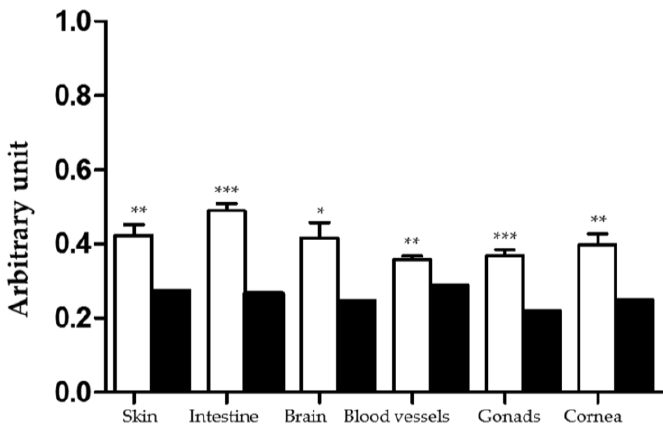
Figure 6. Cell adhesion (arbitrary units) on PEO(5%)coHSAm(5%)fb(0.5%) IPNs (white) and Thermanox ® (black) after seven days of culture. The dissociation curve (percent of detached cells as a function of time) was plotted after enzymatic dissociation. An index representative of the inverse of the area between the dissociation enzymatic curve and the x-axis was calculated and used to express cell adhesion. Data, compared to the Thermanox ® group, were analyzed using Student’s t -test, * p ≤ 0.05, ** p ≤ 0.001 and *** p ≤ 0.0001 compared to the Thermanox ® group.